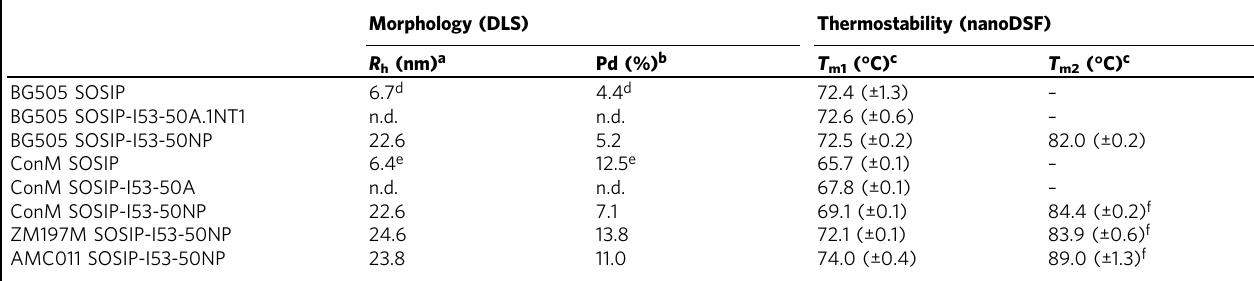
Table 1 Morphology and thermostability of SOSIP-I53-50NPs